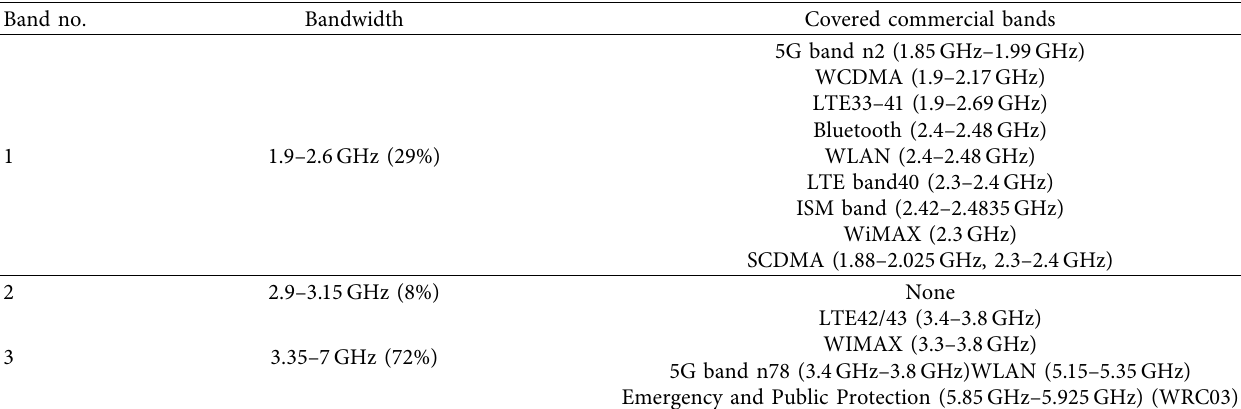
Table 2: Simulated frequency bands covered by the antenna.